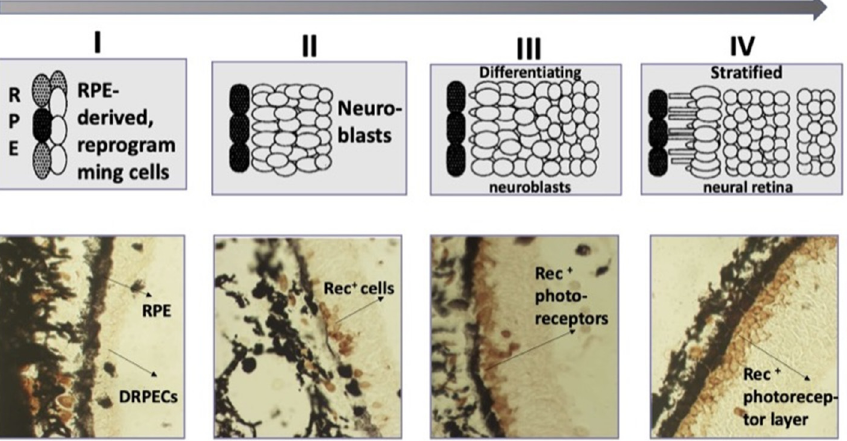
Figure 5. Regeneration of the retina in caudate amphibians. Above: ( I )—the exit of RPE cells from the layer, the loss of initial traits and properties (dedifferentiation); ( II )—the formation of an intermediate population of amplifying neuroblasts; ( III )—NR anlage cells exit the cycle of reproduction having accumulated a certain number of their population; ( IV )—NR anlage cells acquire the retinal neuron and glial phenotypes and build stratified matured retina. Lower row: calcium-binding protein recoverin expression in regenerating retina cells in newt that reflects the stages of ONL formation [137]. DRPECs—dedifferentiating RPE-derived cells.